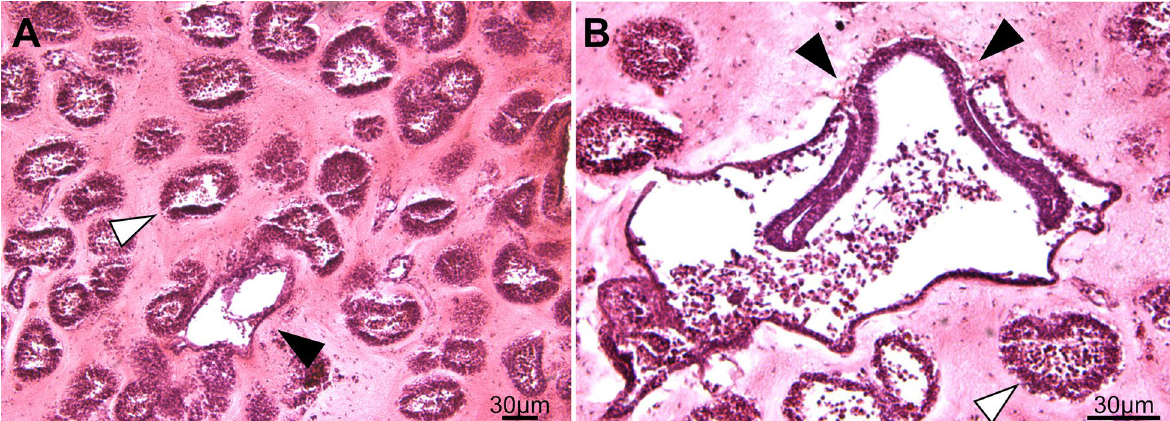
Figure 8. Germination transition in P. zorritensis . Transversal histological sections stained with hematoxylin and eosin of germinating spherule after 48 h at 24 °C. ( A ) The central vessel (black arrowhead) is distinguishable from the ampullary ramifications (one example marked with white arrowhead). ( B ) In a section through the center of the spherule, the vascular epidermis is invaginating (black arrowheads indicate location of the invaginations). White arrowhead indicates ampullary